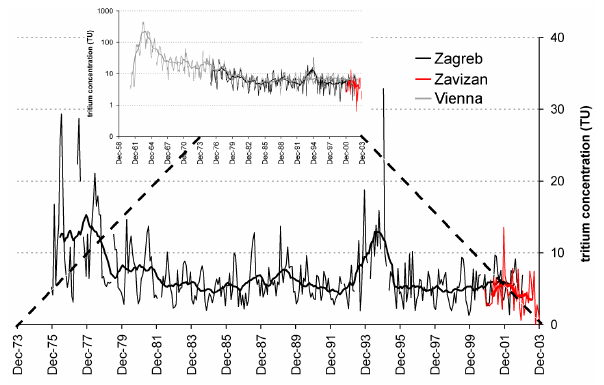
Fig. 4. Decay-corrected tritium activity of past precipitation at Za- vižan (red) and Zagreb (black) over the 1973–2003 period. The inset figure shows the same graphs completed with data from Vi- enna (gray) – the longest regional tritium record. Thin lines show of monthly data, thick lines (12-month moving average) emphasize the annual variability.